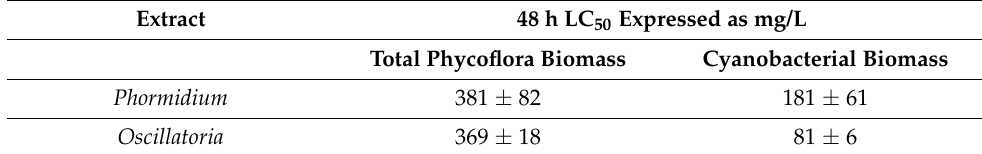
Table 3. Toxicity (48 h LC 50 ) of extracts to D. magna , determined on the basis of the concentration of the total phycoflora biomass and cyanobacterial biomass present in the extracts (mean ± SD; n = 4).